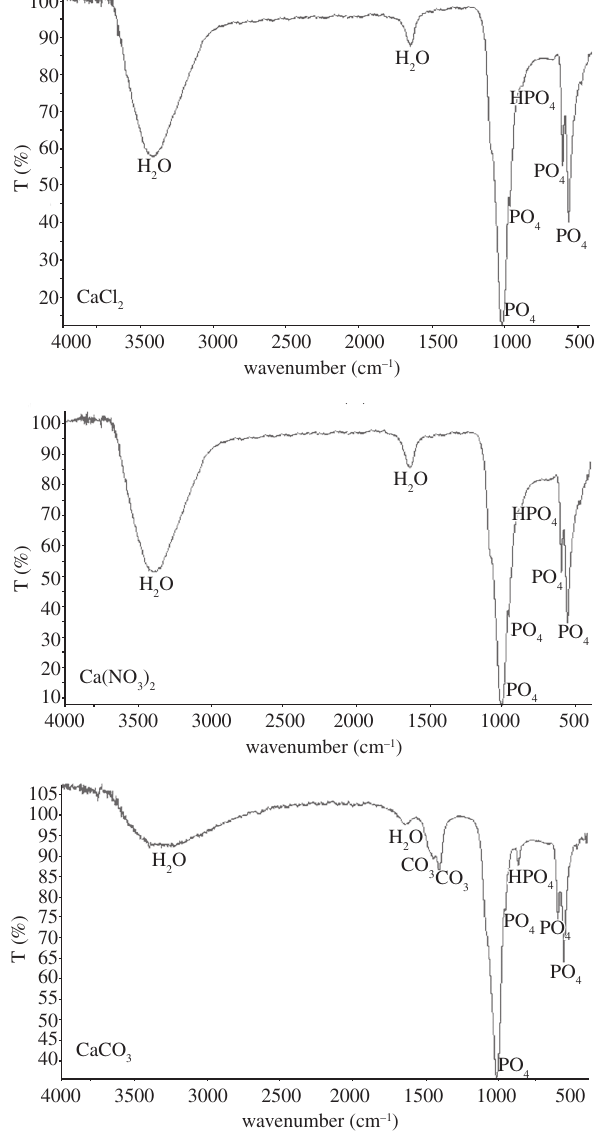
Figure 2. FT-IR spectra of obtained powders.